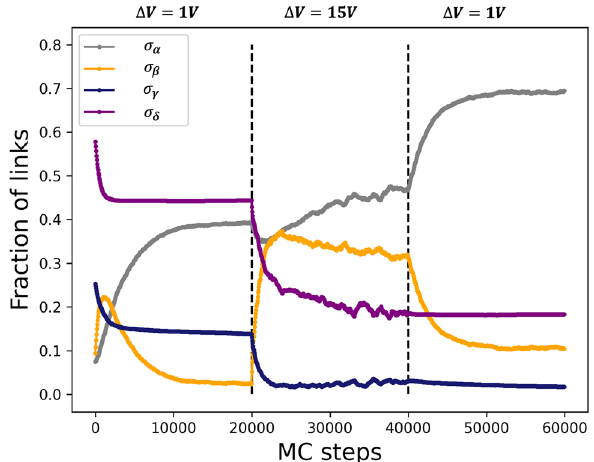
Figure 4. Evolution of the fractions of links with: σ ij = σ α = 10 − 11 � − 1 (grey), σ ij = σ β = 10 − 3 � − 1 (orange), σ ij = σ γ = 2 × 10 − 3 � − 1 (navy) and σ ij = σ δ = 4 × 10 − 3 � − 1 (purple) as a function of the MC steps. Black dashed vertical lines separate the three simulation phases. At the start of the simulation, one can see the initial probability for the abundance of links having conductivity equal to σ α , σ β , σ γ , σ δ . The initial amount of each conductance level is chosen in a range of values which allow for a sufficient degree of current